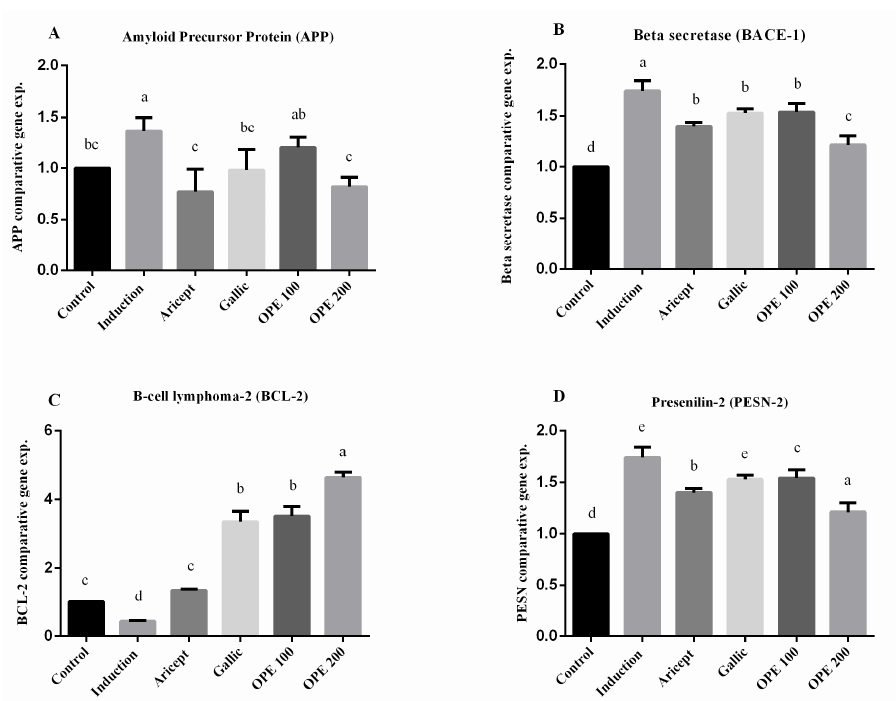
Figure 4. Effect of Aricept, gallic, OPE 100, and OPE 200 on brain (hippocampus) gene expression of amyloid precursor protein (APP) ( A ), beta secretase (BACE-1) ( B ), B-cell lymphoma-2 (BCL-2) ( C ) and presenilin-2 (PSEN-2) ( D ). Values represent the mean ± SD of six rats. ANOVA (one-way) followed by Tukey’s test. Values bearing the same letters showed no significant difference ( p < 0.05). The results are sorted in descending order: a < b < c <d <